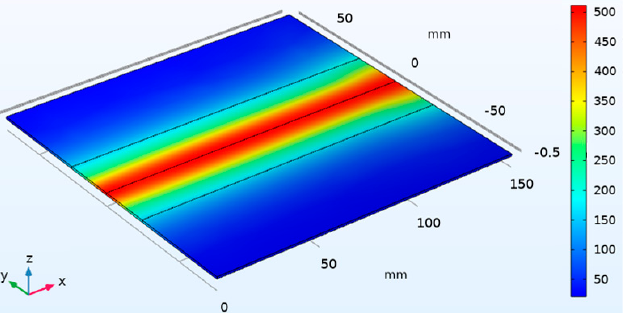
Figure 7. Peak temperatures in the blank at the end of the laser surface treatment (T510V5). The FE model was used to investigate different treatment speeds and peak temper- atures. In the simulation plan, the treatment speeds of 5 mm/s and 7.5 mm/s were